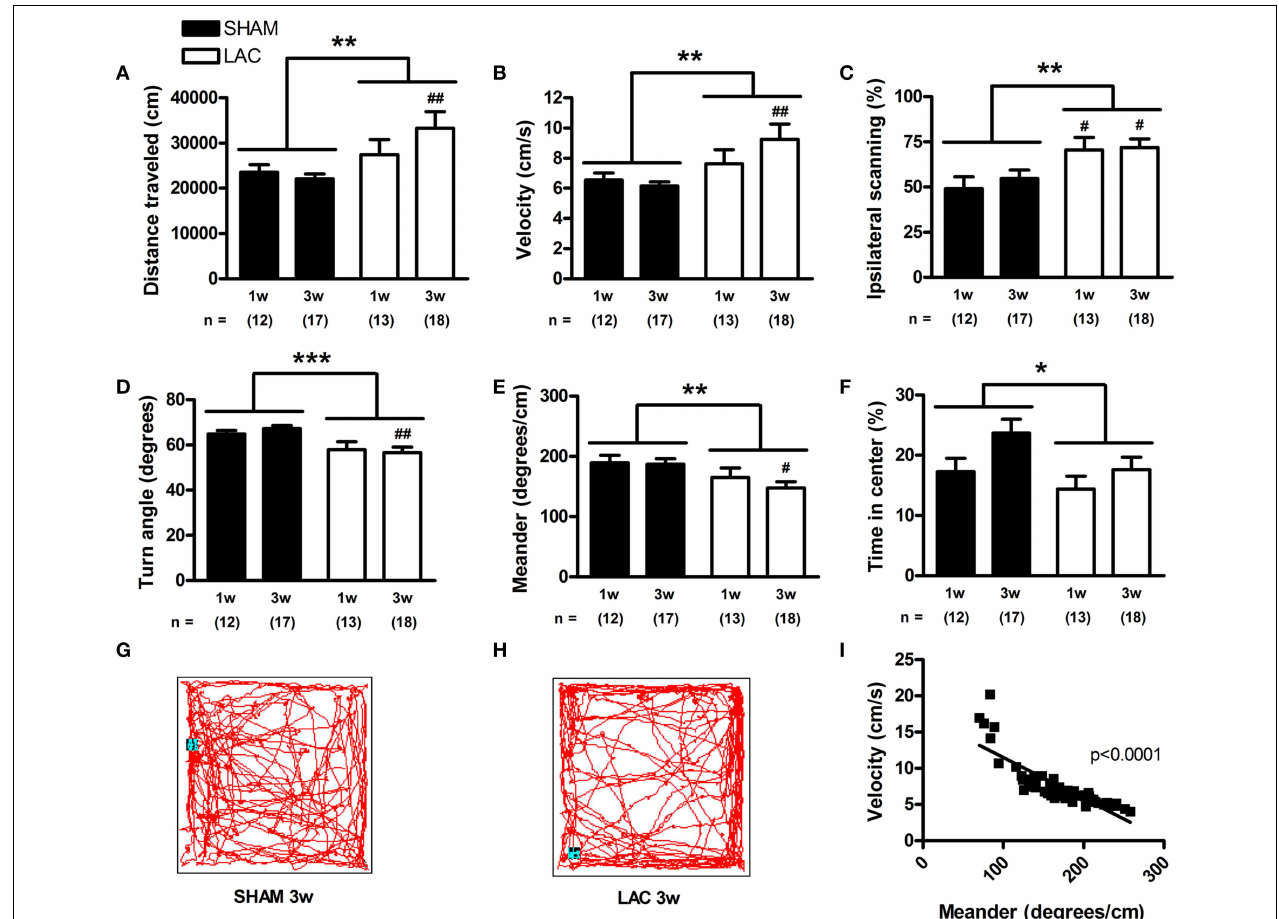
FIGURE 5 | Spontaneous behavior of mice treated with 3 µ g LAC as observed in a 60min open-field test. Distance traveled (A) , and velocity (B) were globally increased in LAC lesioned mice, compared to sham mice receiving vehicle. Furthermore, mice treated with LAC had significantly increased ipsilateral scanning behavior (C) . LAC lesion also induced global decreases in turn angle (D) , as well as in meander (E) . This perseverative behavior is reflected in representative 10min trajectories of a sham-treated (G) , and a LAC-treated (H) mouse at 3